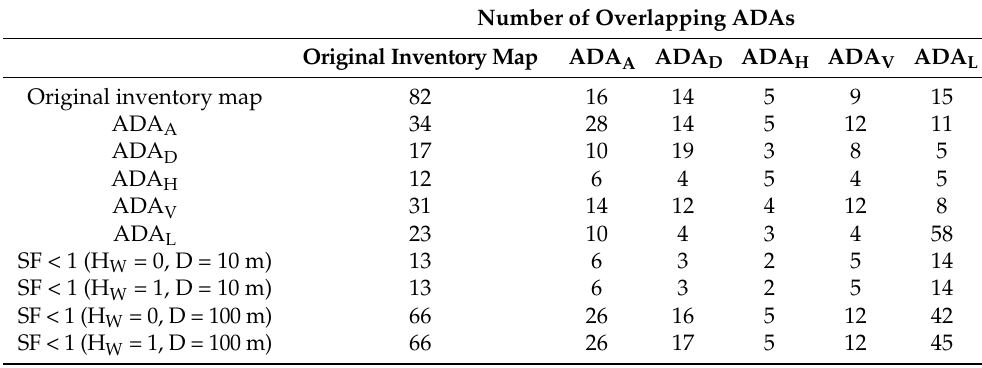
Table 5. Confusion matrix to analyze the overlapping number of polygons.